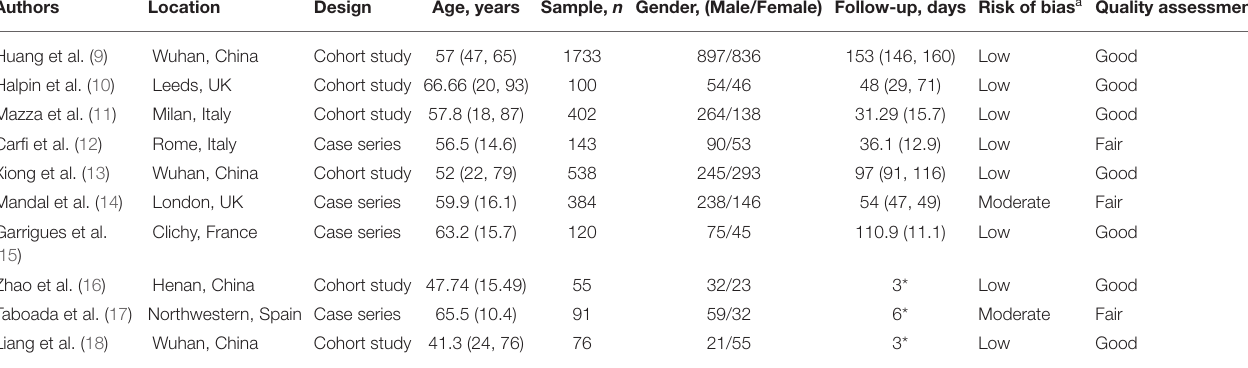
TABLE 1 | Characteristics of included